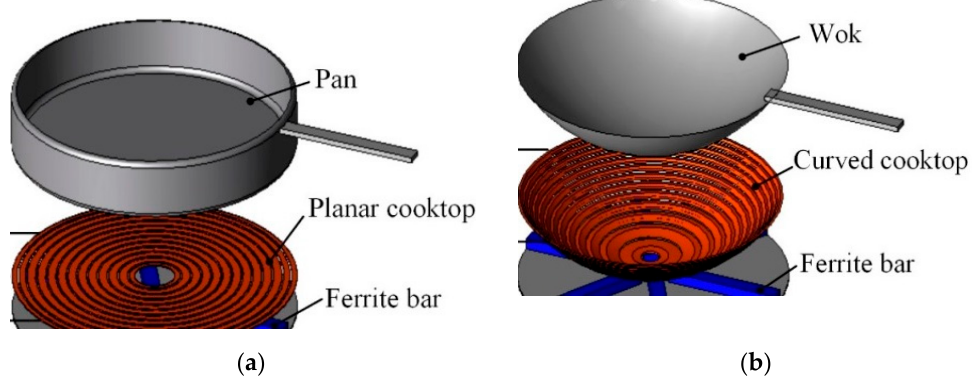
Figure 1. Heating metal of different shapes and sizes: ( a ) planar cooktop and ( b ) curved